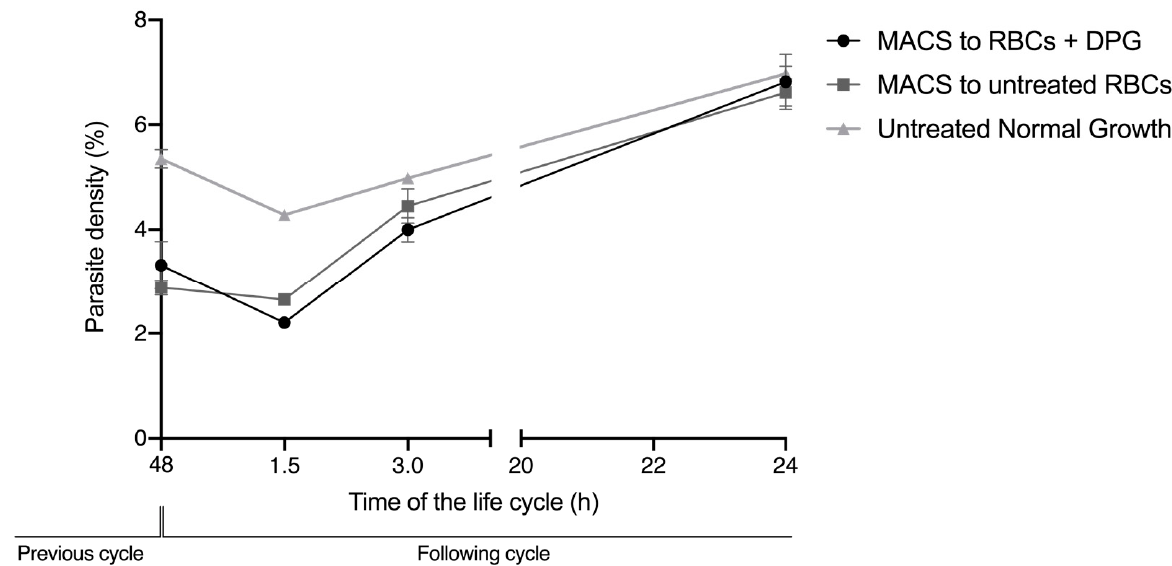
Figure 6. Total parasite density of infected RBCs during the reinvasion assay, measured by flow cytometry in at 0, 1.5, 3 and 24 h of the new development cycle. MACS to RBCs + DPG—iRBCs re-cultured in 2,3-DPG treated RBCs after magnetic enrichment of schizonts; MACS to untreated RBCs—iRBCs re-cultured in untreated RBCs after magnetic enrichment of schizonts; Untreated Normal Growth—iRBCs from cultures allowed to grow for a full developmental cycle under standard conditions. These data are representative of three independent experiments performed in triplicate. (MACS to RBCs + DPG—0 h, Mean ± SD = 3.31% ± 0.46; 1.5 h, Mean ± SD = 2.21% ± 0.09; 3 h, Mean ± SD = 4.00% ± 0.23; 24 h, Mean ± SD = 6.82% ± 0.53; MACS to untreated RBCs—0 h, Mean ± SD = 2.88% ± 0.15; 1.5 h, Mean ± SD = 2.65% ± 0.11; 3 h, Mean ± SD = 4.45% ± 0.33; 24 h, Mean ± SD = 6.61% ± 0.26; Untreated Normal Growth—0 h, Mean ± SD = 5.35% ± 0.18; 1.5 h, Mean ± SD = 4.28% ± 0.03; 3 h, Mean ± SD = 4.98% ± 0.09; 24 h, Mean ± SD = 6.97% ± 0.14).